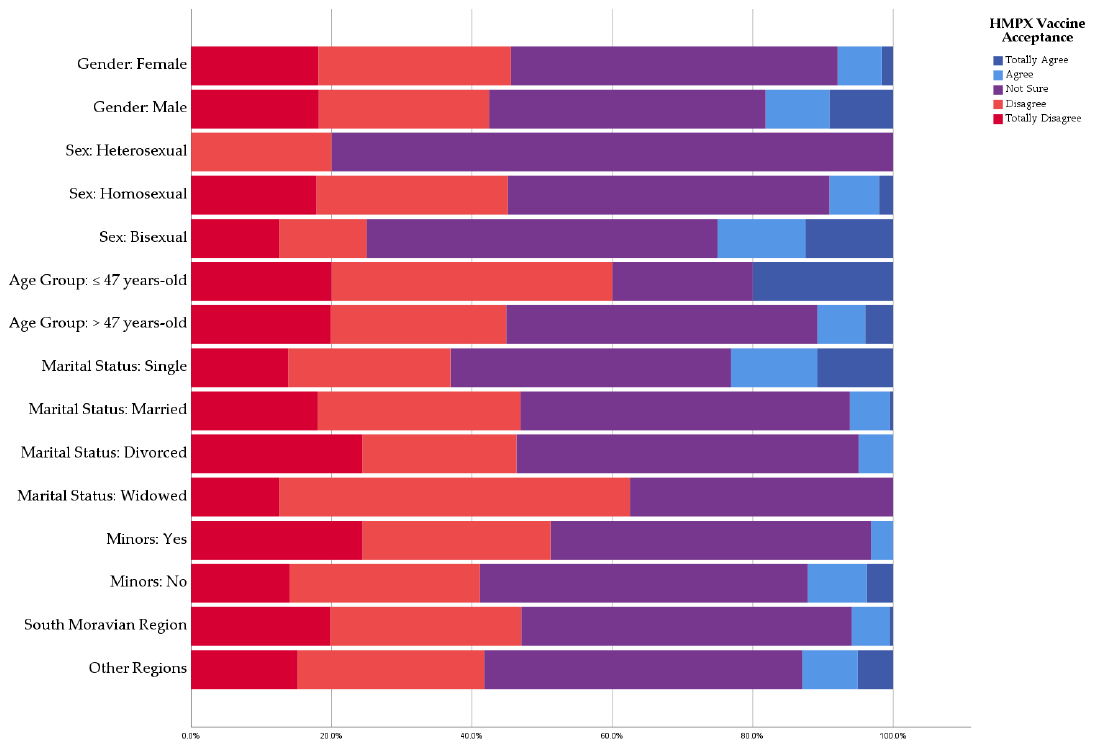
Figure 4. Anamnestic predictors of HMPXV vaccine acceptance among Czech HCWs, September 2022 ( n = 341).